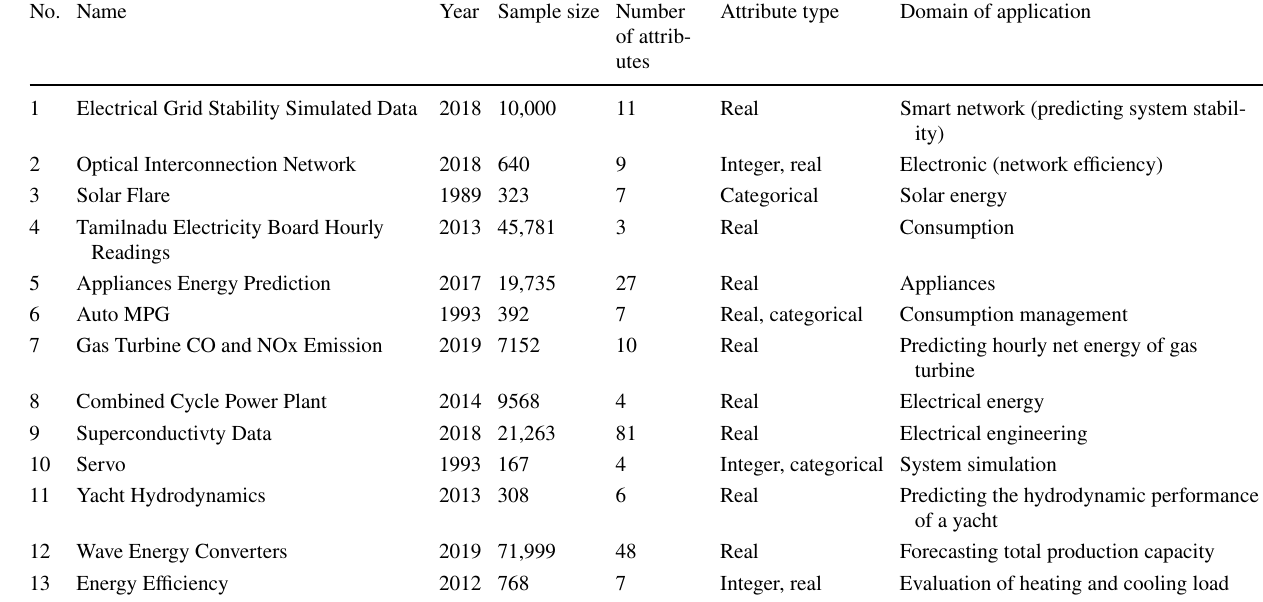
Table 1 The general characteristics of the selected benchmarks No. Name